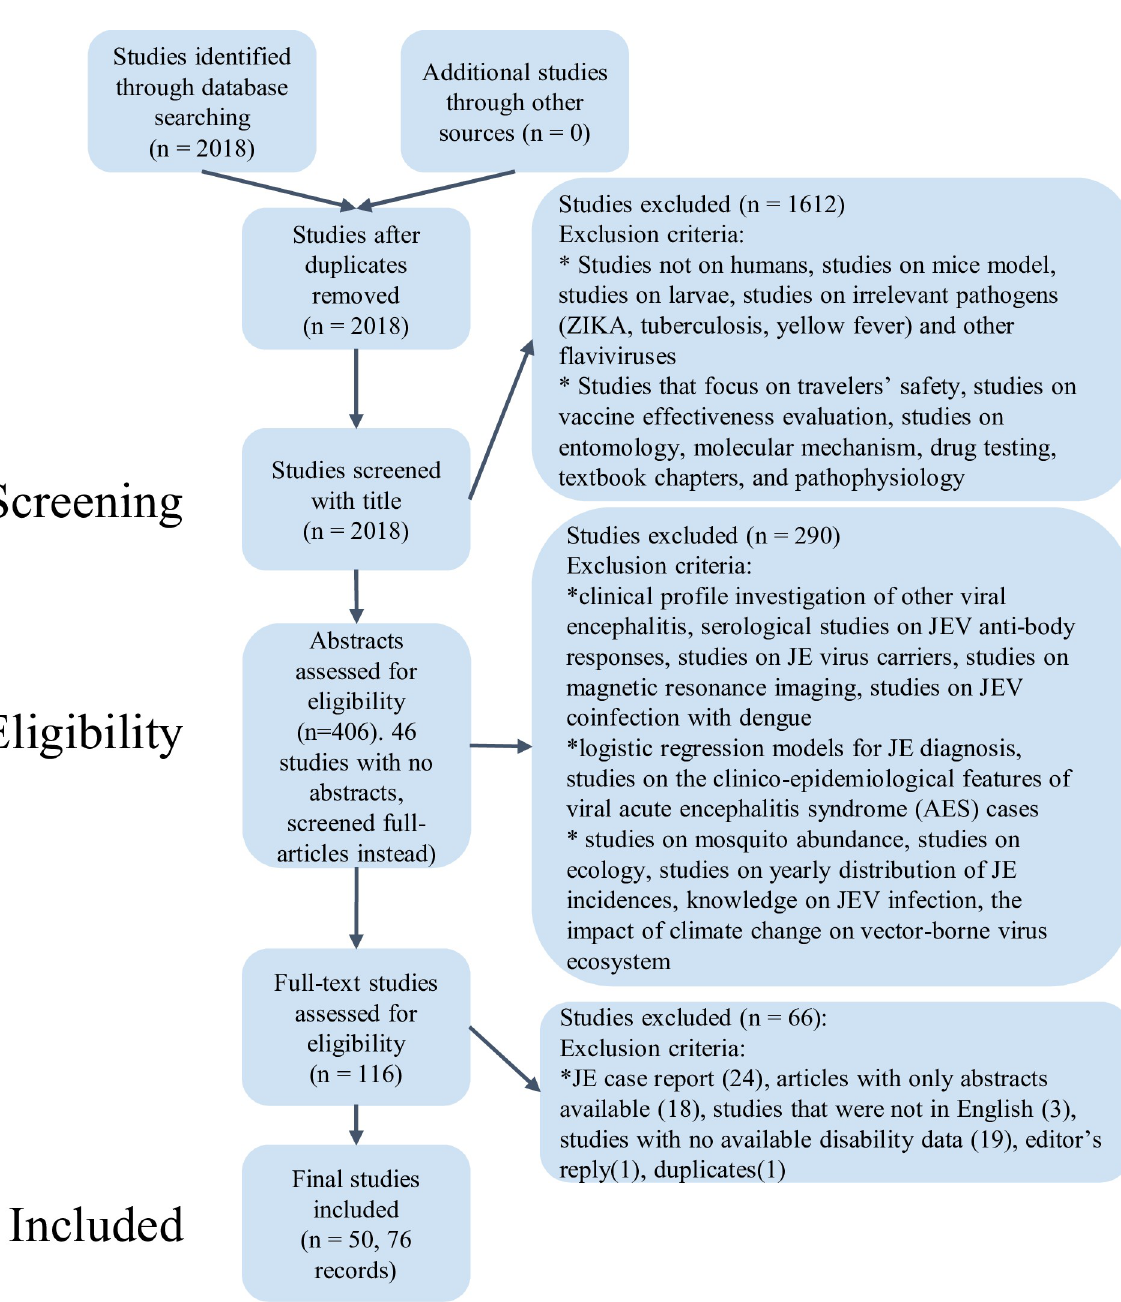
Fig 5. Flowchart describing the systematic review procedure searching for Japanese encephalitis (JE) neurological sequelae records using PubMed database.